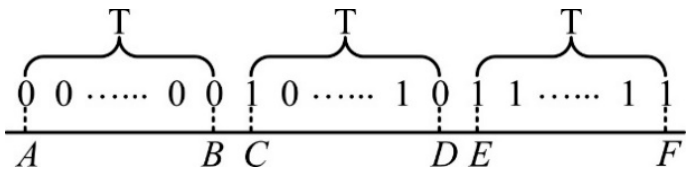
Figure 1. The principle for generating an intermediate gray region.